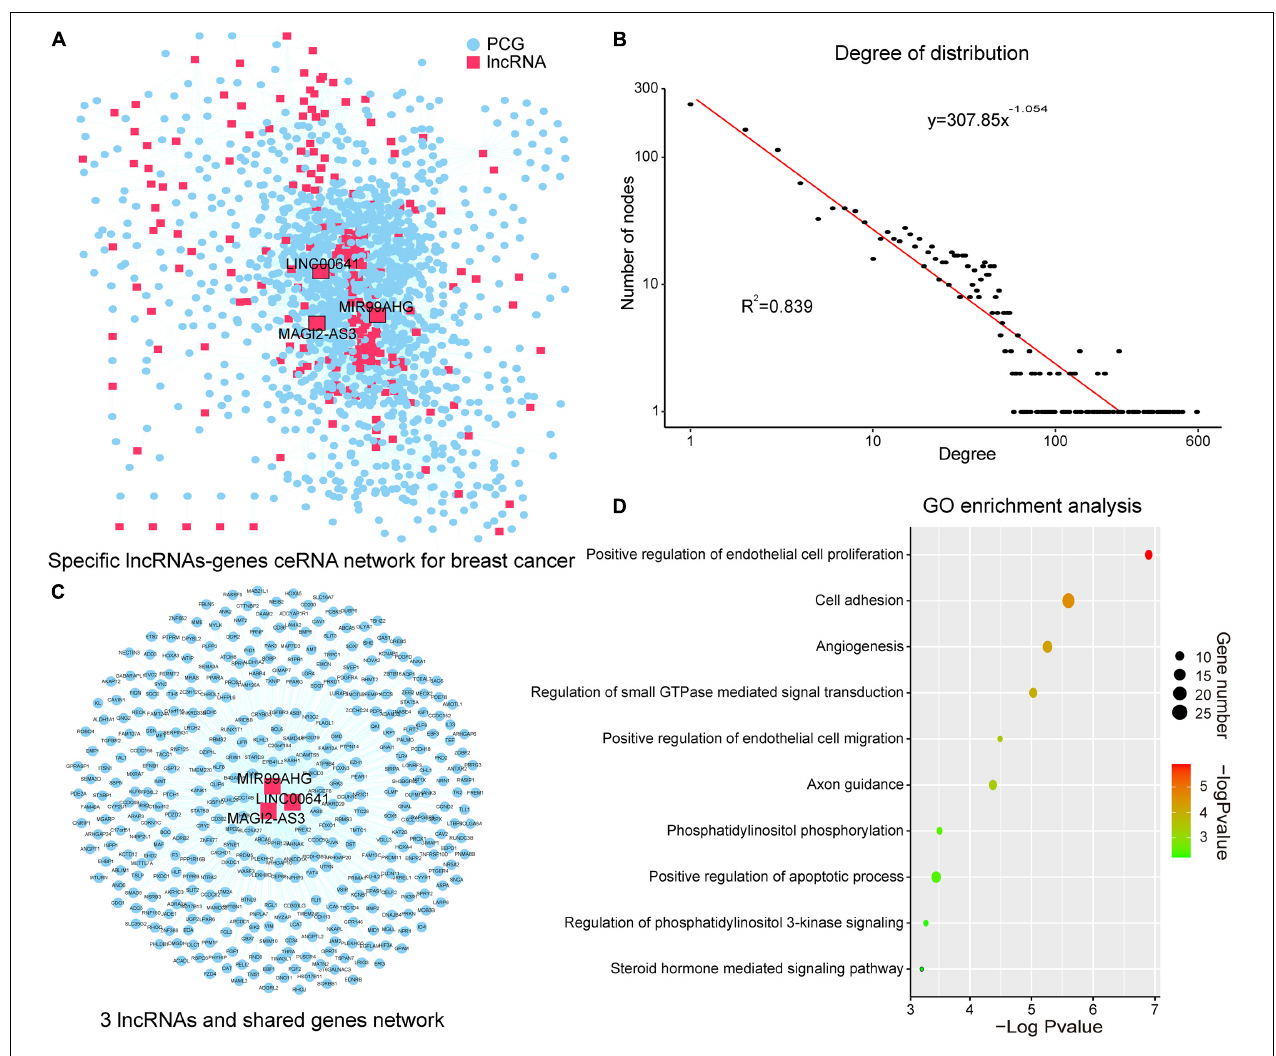
FIGURE 2 | SLGCeNBC and three lncRNAs appeared in two dimensions. (A) SLGCeNBC. The red and blue nodes represent lncRNAs and PCGs, respectively. A lncRNA and PCG were connected by an edge if they had the ceRNA and co-expression relationships ( Supplementary Table 2 ). (B) The true node degree distribution of SLGCeNBC; the degree distribution of all nodes followed the power law distribution approximately with a slope of –1.054 and R 2 = 0.839. (C) The lncRNAs (MAGI2-AS3, MIR99AHG, and LINC00641) are ranked in the top 20 in at least two dimensions (degree, betweenness, and closeness). (D) GO